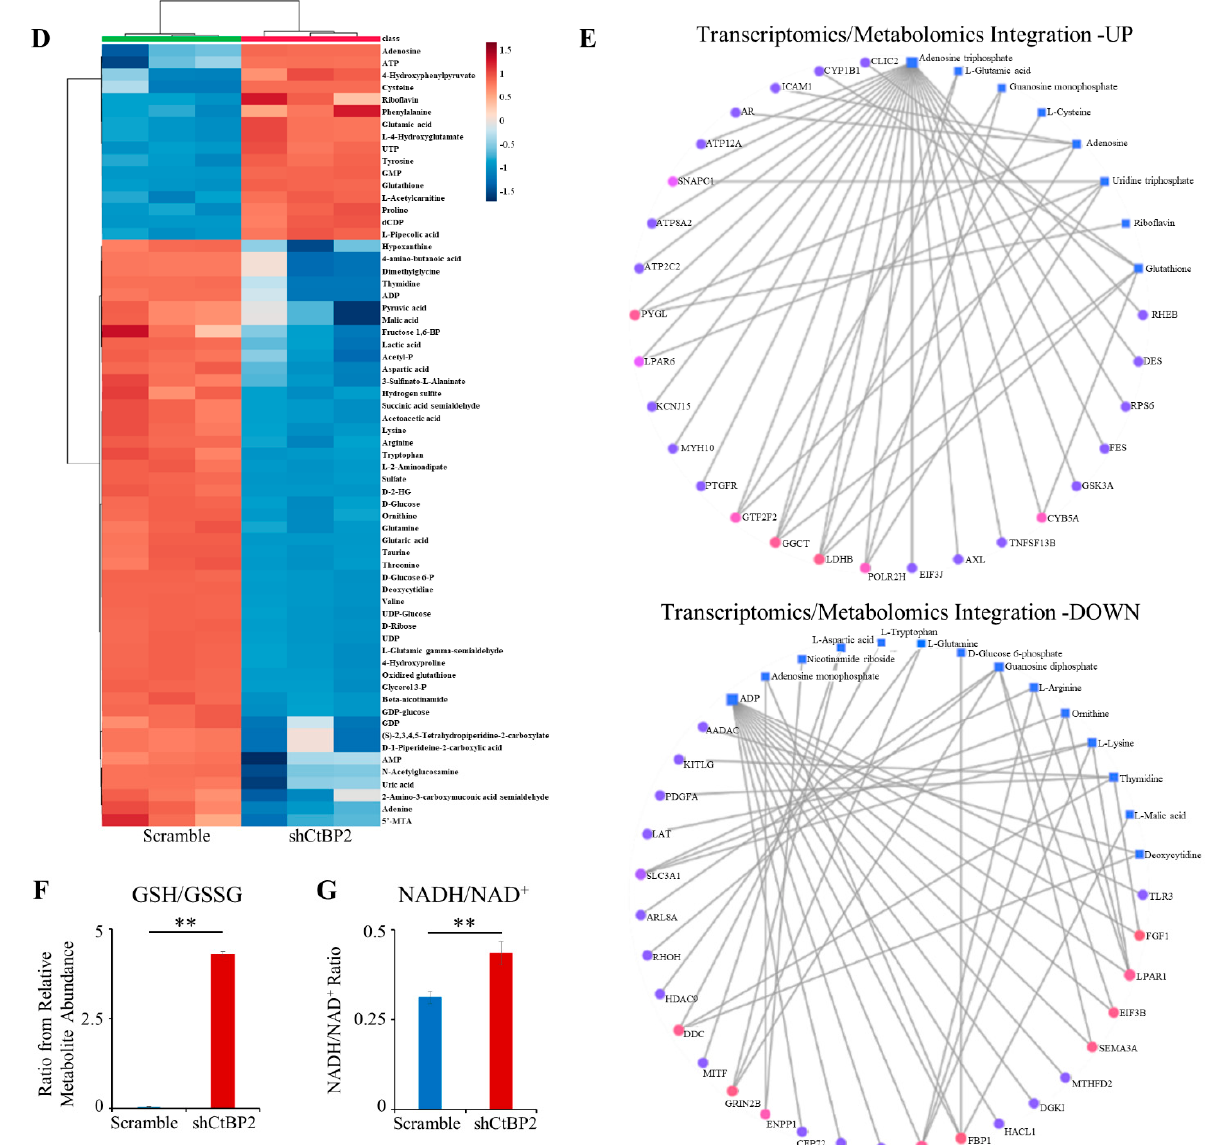
Figure 3. Transcriptomics/metabolomics integration of the shCtBP2 MDA-MB231 cell line. ( A ) mRNA levels expressed as a fold change of CtBP2 in shCtBP2 relative to scramble in MDA-MB231 cells, normalized for GAPDH mRNA expression (left panel); representative image of western blot analysis of MDA-MB231 cells, reporting CtBP2 and vinculin expression in shCtBP2 compared to scramble cells (middle panel); and relative densitometry analysis of CtBP2 expression in shCtBP2 relative to scramble cells (right panel) (relative uncropped western blot and densitometry signals can be found in File S2B). ( B ) Hierarchical clustering and heatmap of differentially expressed genes in MDA-MB231 cells between scramble and shCtBP2. The colors represent different expression levels that increase from blue to yellow. ( C ) Gene ontology enrichment analysis of the biological process of differentially expressed genes between MDA-MB231 scramble and shCtBP2 represented as a pie chart. ( D ) Untargeted metabolic profiling of MDA-MB231 scramble and shCtBP2 cells grown under standard growth conditions. Hierarchical clustering heatmap, obtained by Metaboanalyst 5.0, shows significantly different intracellular metabolites by LC-MS. ( E ) Gene–metabolite interaction networks of up (upper panel) and down (lower panel)-regulated genes, and metabolites in MDA-MB231 shCtBP2 cells compared to scramble cells, obtained by Metaboanalyst 5.0. Metabolites are represented as squares and genes are represented as circles. The size of the features corresponds to its node degree and the gene circle color corresponds to its betweenness centrality values (from fuchsia, which is the highest, to blue, which is the lowest). ( F ) GSH/GSSG ratio in MDA-MB231 scramble and shCtBP2 cells based on relative abundance obtained by LC-MS analysis. ( G ) NADH/NAD + ratio in MDA-MB231 scramble and shCtBP2 cells obtained by colorimetric assay. Error bars indicate SD ( n = 3). ** p -value < 0.005; * p -value <